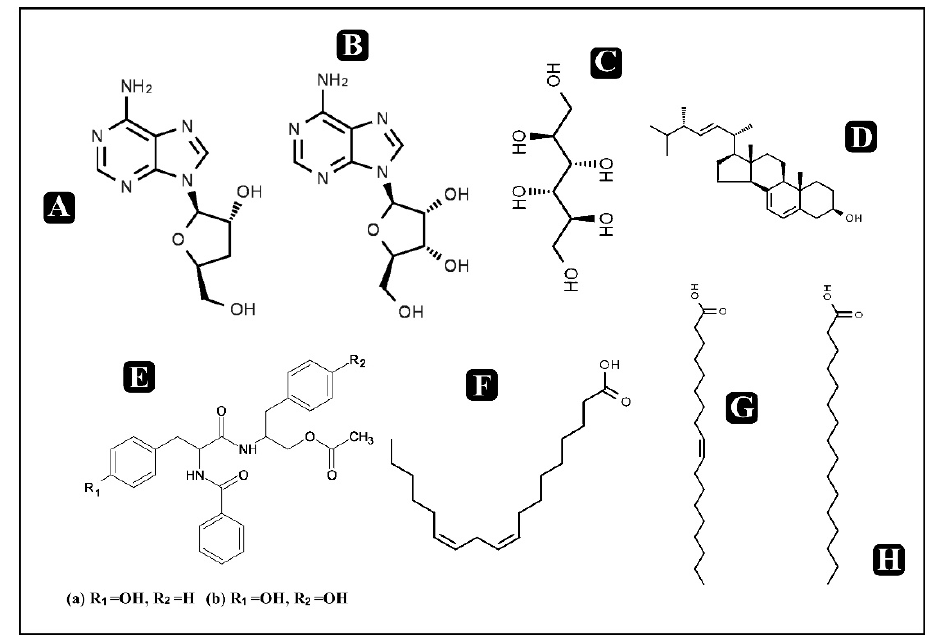
Figure 1. Chemical structures of some known and potent bioactive compounds in Cordyceps. ( A ) Cordycepin ( B ) Adenosine ( C ) Cordycepic acid ( D ) Ergosterol ( E ) Structure of (a) and (b). (a)